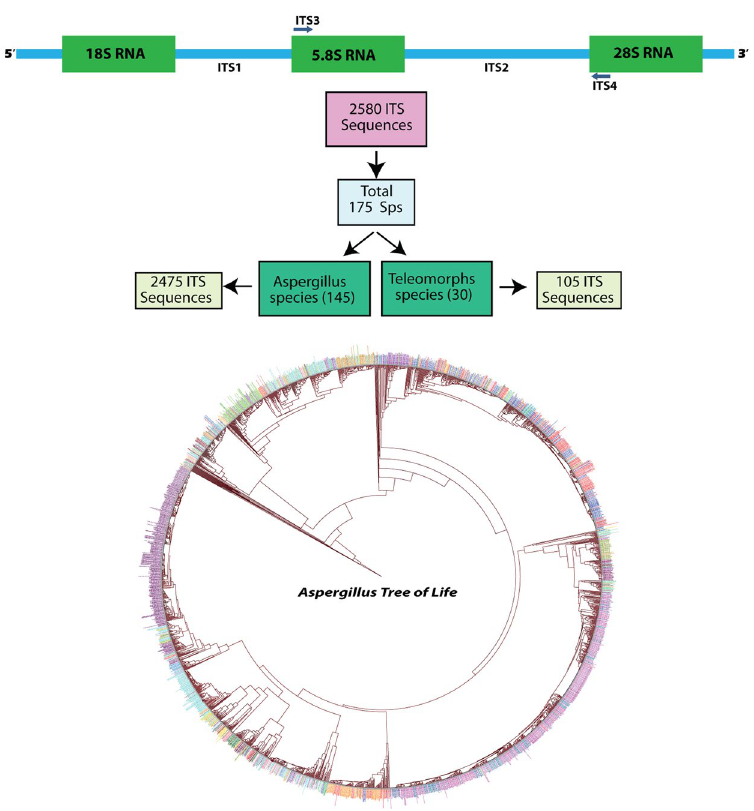
Figure 6. Phylogenetic tree of life for 2850 Aspergillus strains using ITS sequences. All the sequences are unique, various strains of Aspergillus belong mainly to 175